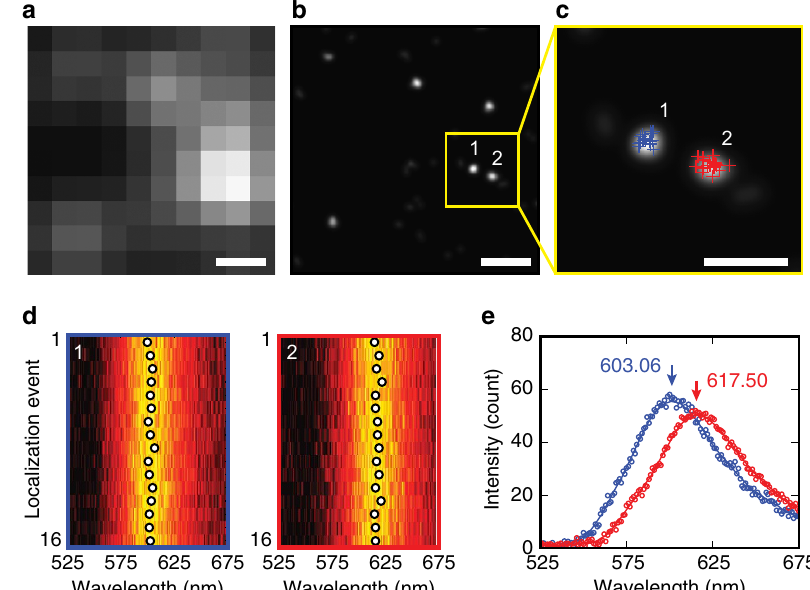
Figure 2 | Differentiating individual molecules by exploiting their heterogeneous fluorescence. ( a ) Wide-field optical image and ( b ) PLM image of actin monomers labelled by Alexa Fluor 568. PLM image was reconstructed from localization coordinates using localization precision as the full-width at half-maximum of a Gaussian kernel. ( c ) Two nearby clusters are highlighted and localization coordinates are marked by crosses. Scale bars, 200nm ( a , b ); 100nm ( c ). ( d ) Emission spectra denoted by coloured circles in c . ( e ) The corresponding averaged spectra of these two clusters showing distinct emission